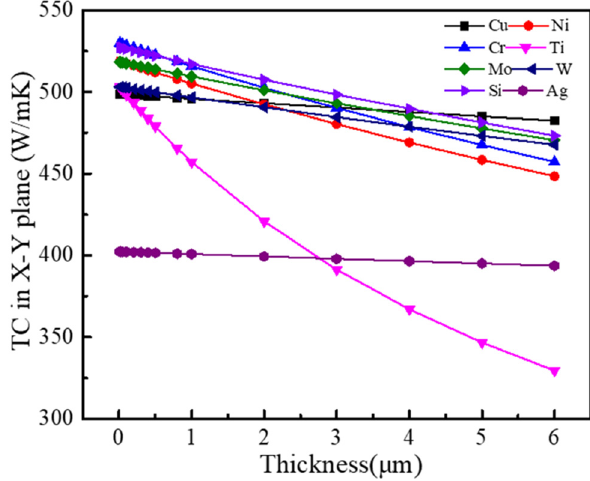
Figure 5: TC of graphite fl akes/Al composites with typical metal coatings as a function of coating thickness.